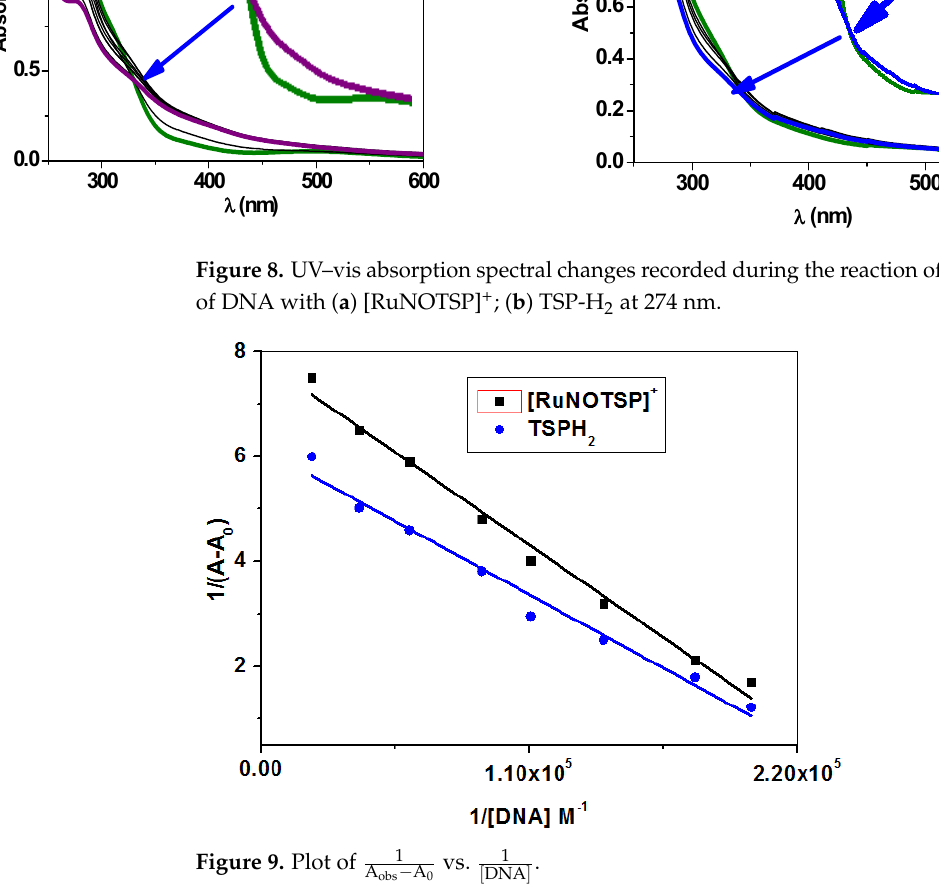
Figure 9. Plot of (cid:2869)